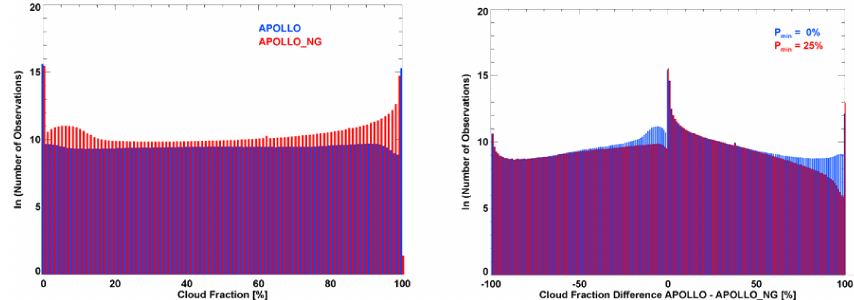
Figure 7. Left – cloud fraction histograms of APOLLO (red) and APOLLO_NG (blue) for the central overpass of NOAA-19 on 15 July 2013. Right – histograms of the cloud fraction difference between APOLLO and APOLLO_NG for all cloud probability values (blue) and with all observations having cloud probability smaller than 25% set to cloud free